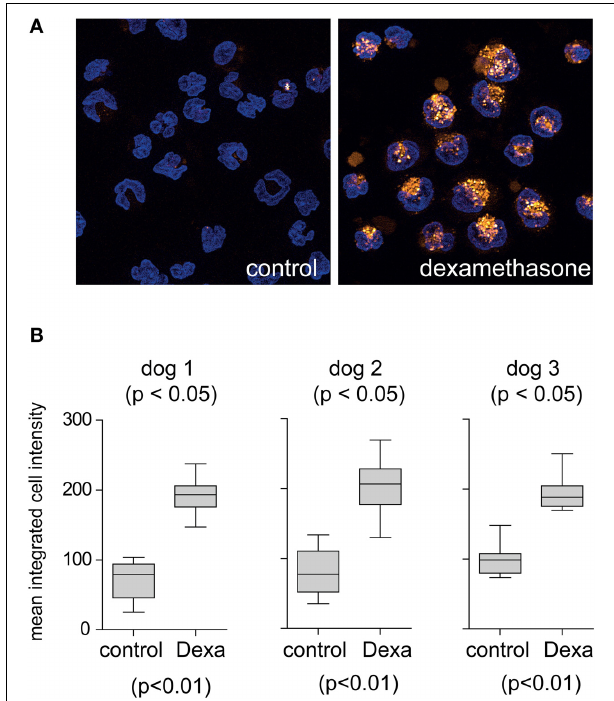
FIGURE 1 | Glucocorticoid induction of the dog macrophage Hb:Hp clearance system. (A) Peripheral blood CD14 + monocytes from beagle dogs were cultured for 36h in the presence of M-CSF (control) or M-CSF + dexamethasone (2.5 × 10 − 7 M) before they were incubated with fluorescent dog Hb:Hp complexes for 30min. Images represent maximum orthogonal projections of z-stack images acquired with an Apotome fluorescence microscopy system. Blue: nuclei; orange: Hb:Hp complex. Original optical magnification 400x. (B) Hb:Hp upake was quantified by digital image analysis in control and dexamethasone treated macrophages from three different beagle dogs, each condition is represented by 15 individual random